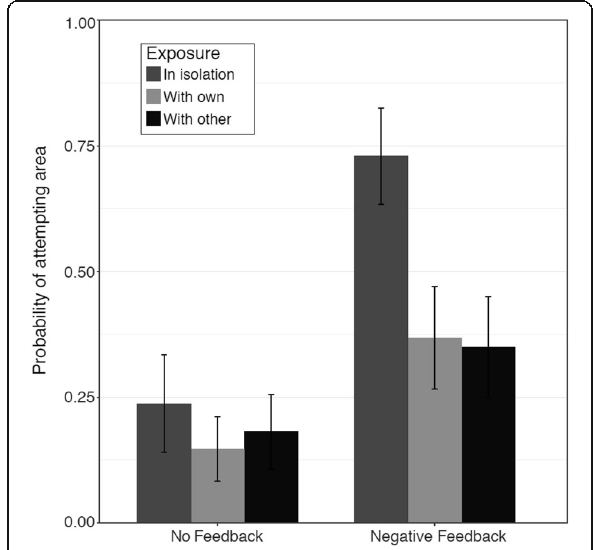
Fig. 4 The probability of adopting the target (area) strategy in each condition in Study 1. The control condition is not depicted because